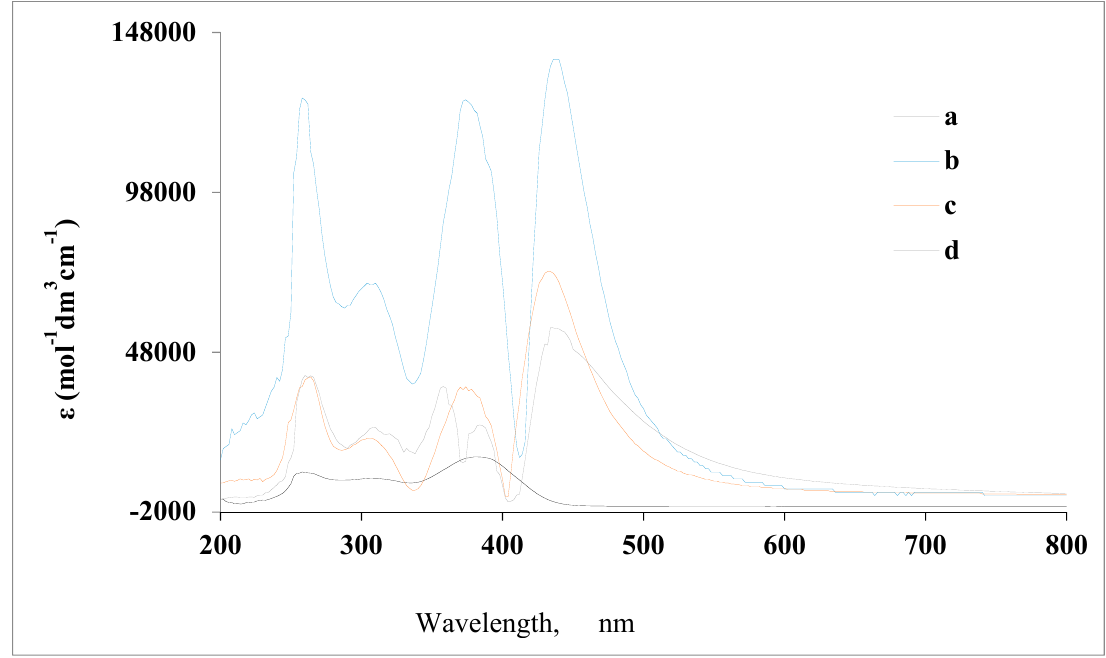
Figure 1. Electronic spectra recorded in aqueous media of ( a ) 4-amino-3-mercapto-6-[2-(2-thienyl)vinyl]-1,2,4-triazin-5(4H)-one (AMT) ligand at concentration of 1.2 × 10 − 4 mol L − 1 and following addition of the Cu(II)-AMT complex at Cu 2+ concentrations of ( b ) 0.70 μ g/mL, ( c ) 3.50 μ g/mL, and ( d ) 5.50 μ g/mL.